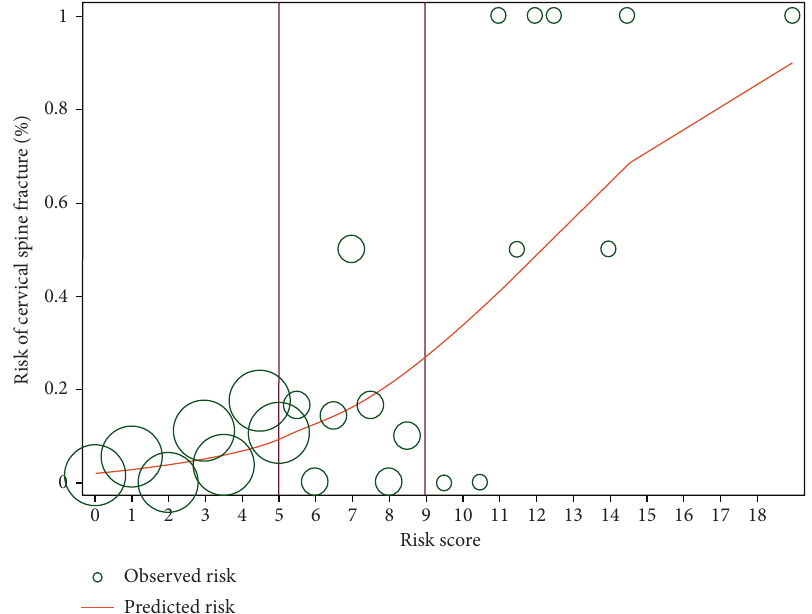
Figure 3: Observed risk (circle) versus score-predicted risk (solid line) of cervical spine